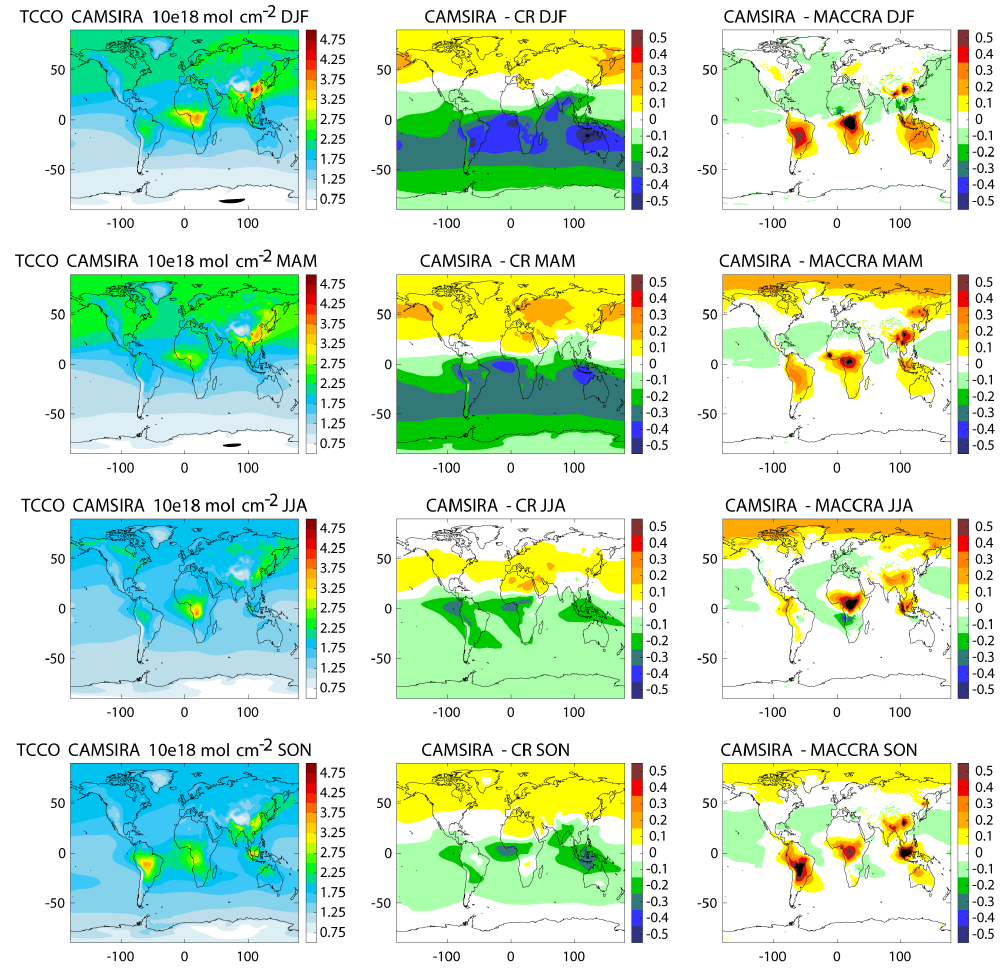
Figure 2. Average TC CO (10 18 molcm 2 ) of CAMSiRA (2003–2015, left) and difference compared to the CR (2003–2015, middle) and MACCRA (2003–2012, right) for the seasons DJF (row 1), MAM (row 2), JJA (row 3) and SON (row